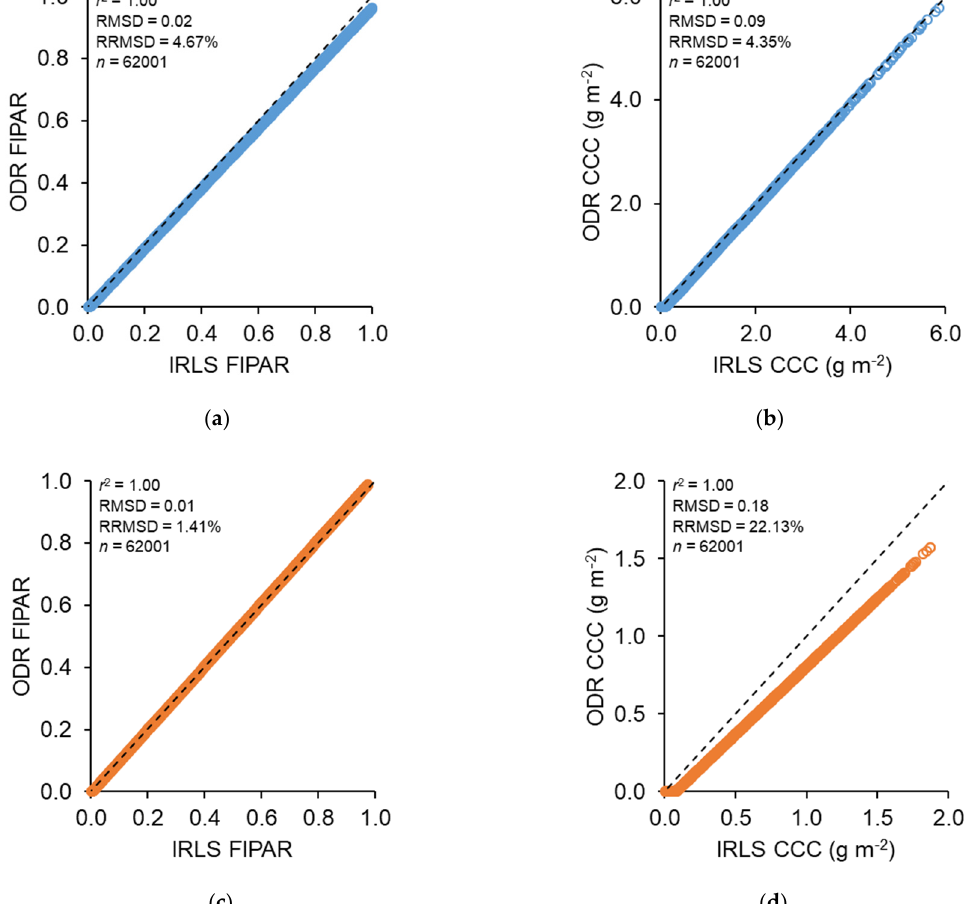
Remote Sens. 2021 , 13 , x FOR PEER REVIEW